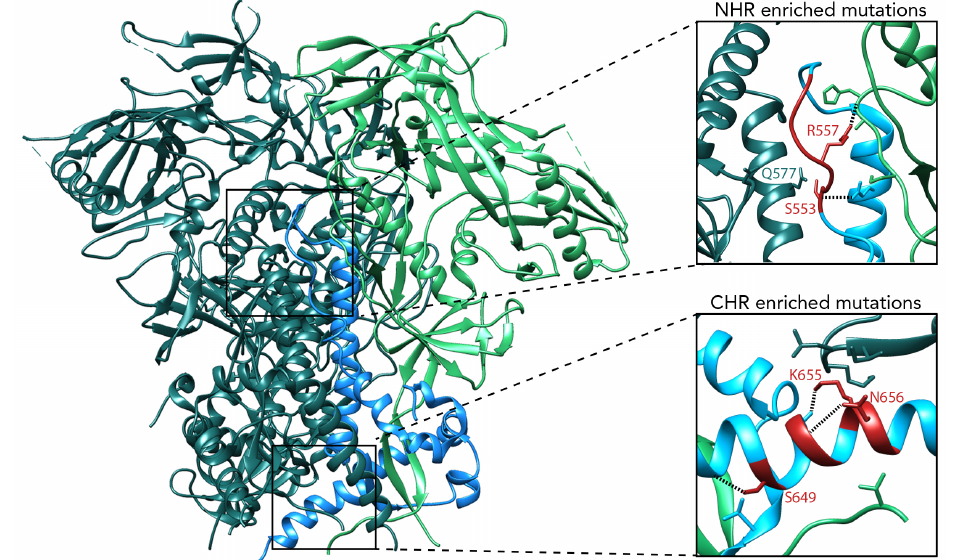
Figure 7. Location and predicted interactions of N-terminal heptad repeat (NHR) and C-terminal heptad repeat (CHR) mutations in the unliganded trimer. The BG505 SOSIP trimer structure (PDB 5CEZ) is shown. Gp120 and gp41 residues of one protomer are shown in bright green and blue respectively. Residues from other protomers are shown in dark green. Upper and lower insets display the regions surrounding the NHR and CHR of one gp41 subunit, respectively. In each inset, residues strongly enriched during the DMS are shown in red. N / CHR residue side chains are shown for amino acids that form predicted H-bond contacts with neighboring residues, and H-bonds are depicted with dotted lines. Side chains are shown for all residues on adjacent subunits that are within 4 angstroms of highly enriched N / CHR